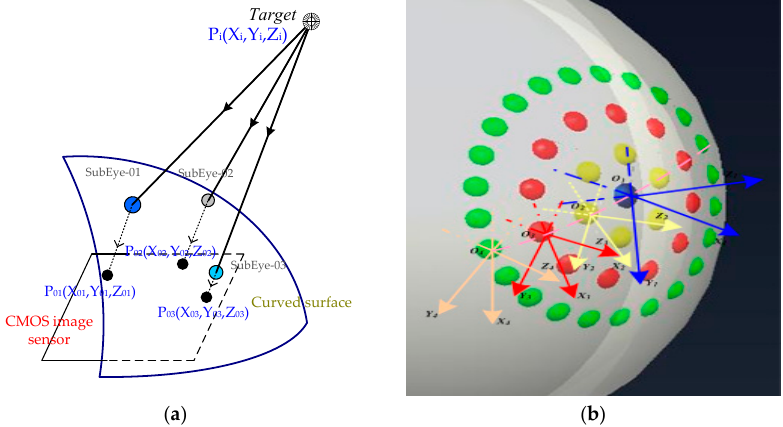
Figure 6. The principle and coordinate transformation of multi-eye positioning in artificial compound eyes: ( a ) the multi-eye positioning principle; and multiple sub-eyes can capture target image; ( b ) subordinate eye coordinate conversion diagram; the coordinate systems of all levels of sub-eyes are different, and coordinate transformation is needed for target positioning.